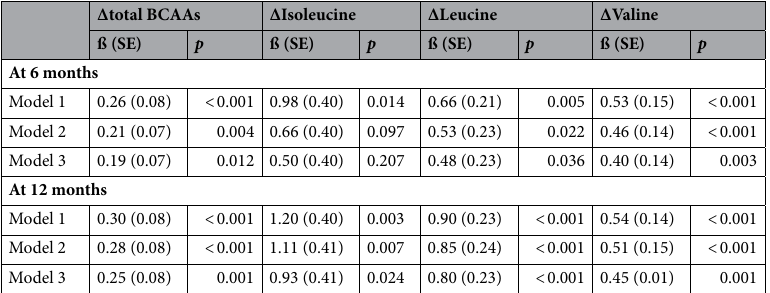
Table 4. Changes (Δ) in liver fat content at 6 months and 12 months per unit of change in BCAAs levels at 6 months. Model 1: adjusted for age, sex, total energy intake, protein intake, intervention groups, HOMA-IR, BMI, liver fat content at baseline, total BCAAs, isoleucine, leucine, and valine at baseline respectively; Model 2: adjusted for covariates in Model 1 + ΔHOMA-IR; Model 3: adjusted for covariates in Model 2 + ΔBMI. Abbreviations: HOMA-IR homeostatic model assessment of insulin resistance; BMI body mass index. ΔHOMA-IR and ΔBMI: changes in HOMA-IR and BMI from baseline to 6